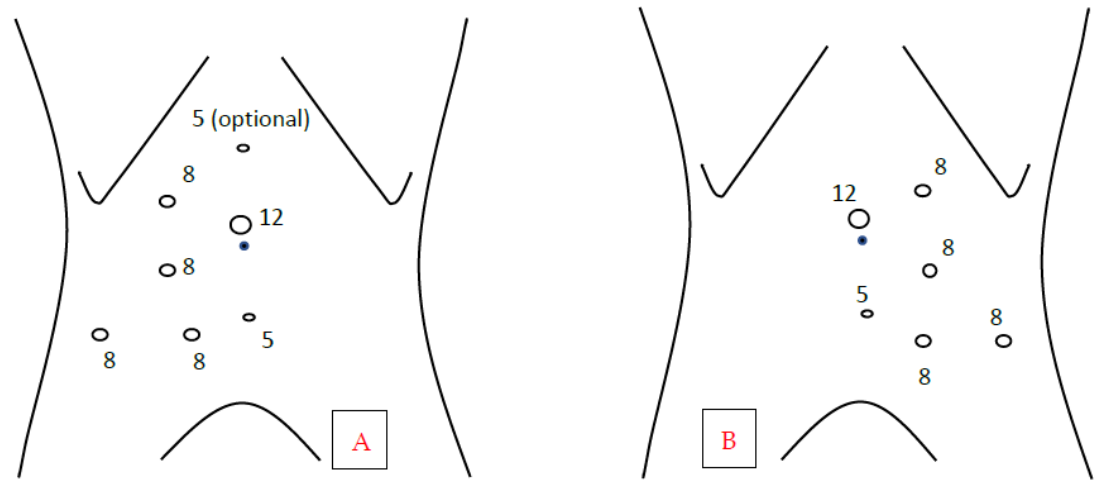
Figure 1. Ports placement template. ( A ): Trocar template for right RALP; ( B ): Trocar template for left RALP. 5 = 5 mm assistant port; 8 = 8 mm robotic port; 12 = 12 mm assistant port. Black dot: umbilicus.